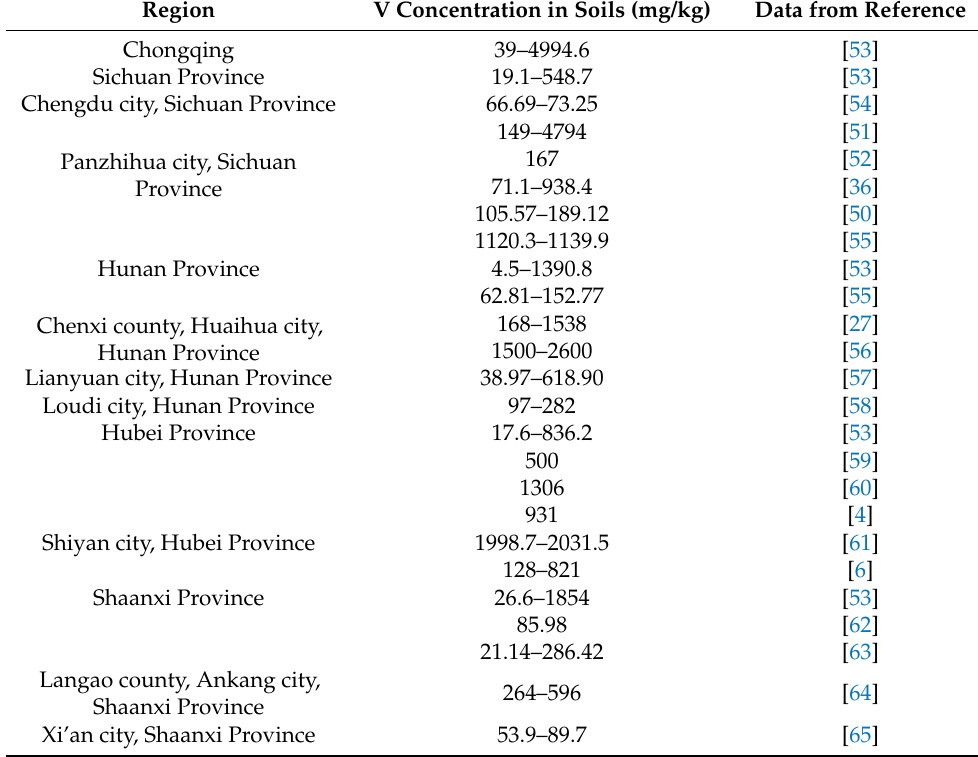
Table 2. V concentrations in contaminated soils of China. Region V Concentration in Soils (mg/kg) Data from